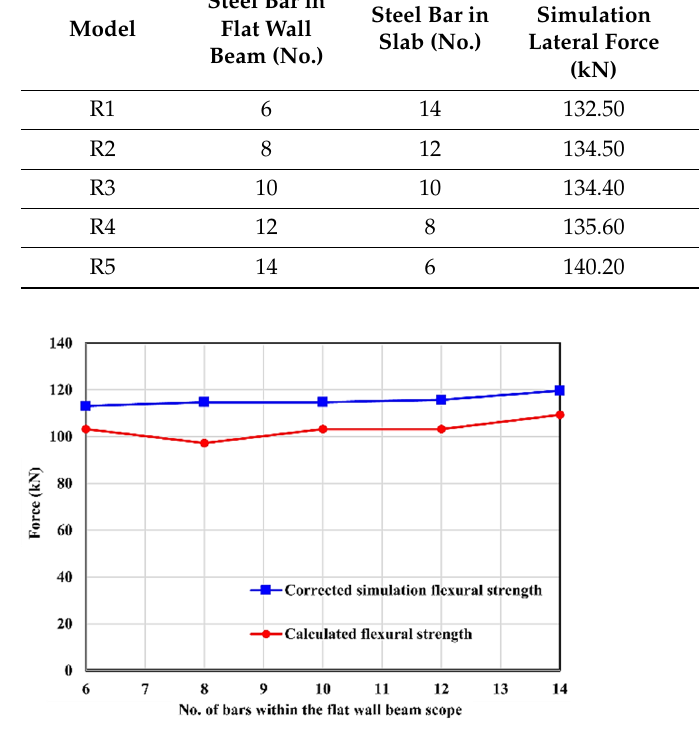
Table 3. FEM results for reinforcement distribution models.